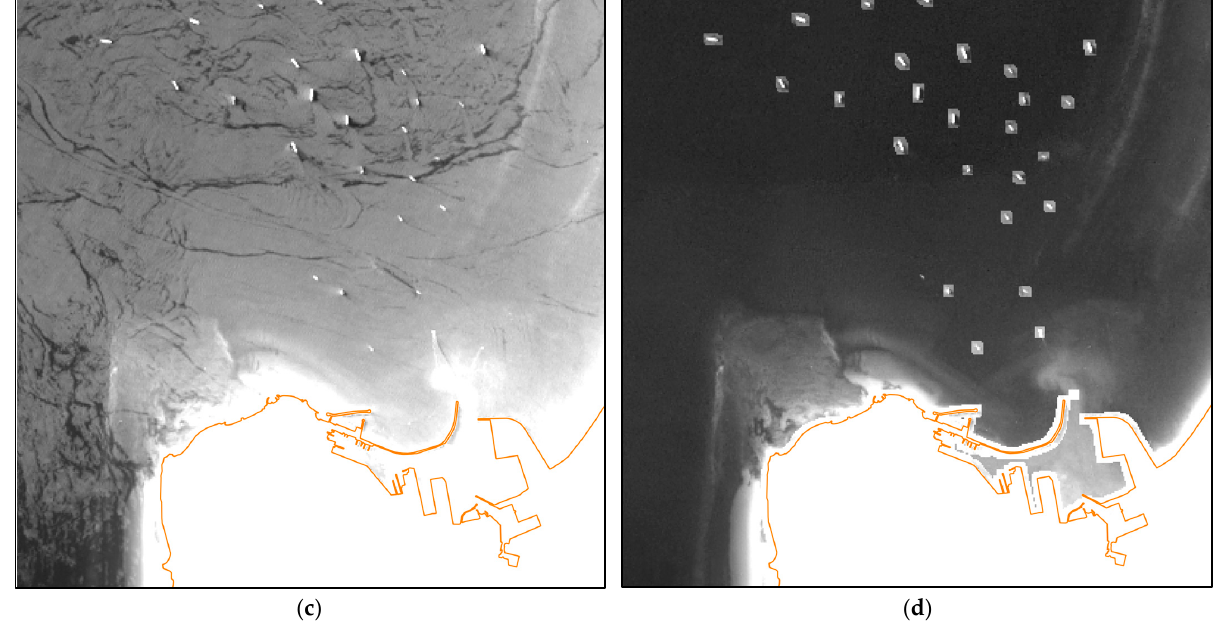
Figure A1. 12 × 12 km² subarea of sample scene HFA-5, Haifa Bay. ( a ) RGB image with glint; ( b ) RGB image glint corrected; ( c ) OLI B3 reflectance with glint; ( d ) OLI B3 reflectance, glint corrected. Although HFA-5 is strongly glint contaminated, GRCM provides visually good results: both the turbid plume off the entry to the harbor basin and the offshore bathymetric features in the lower left and upper right quadrants have become clearly visible.